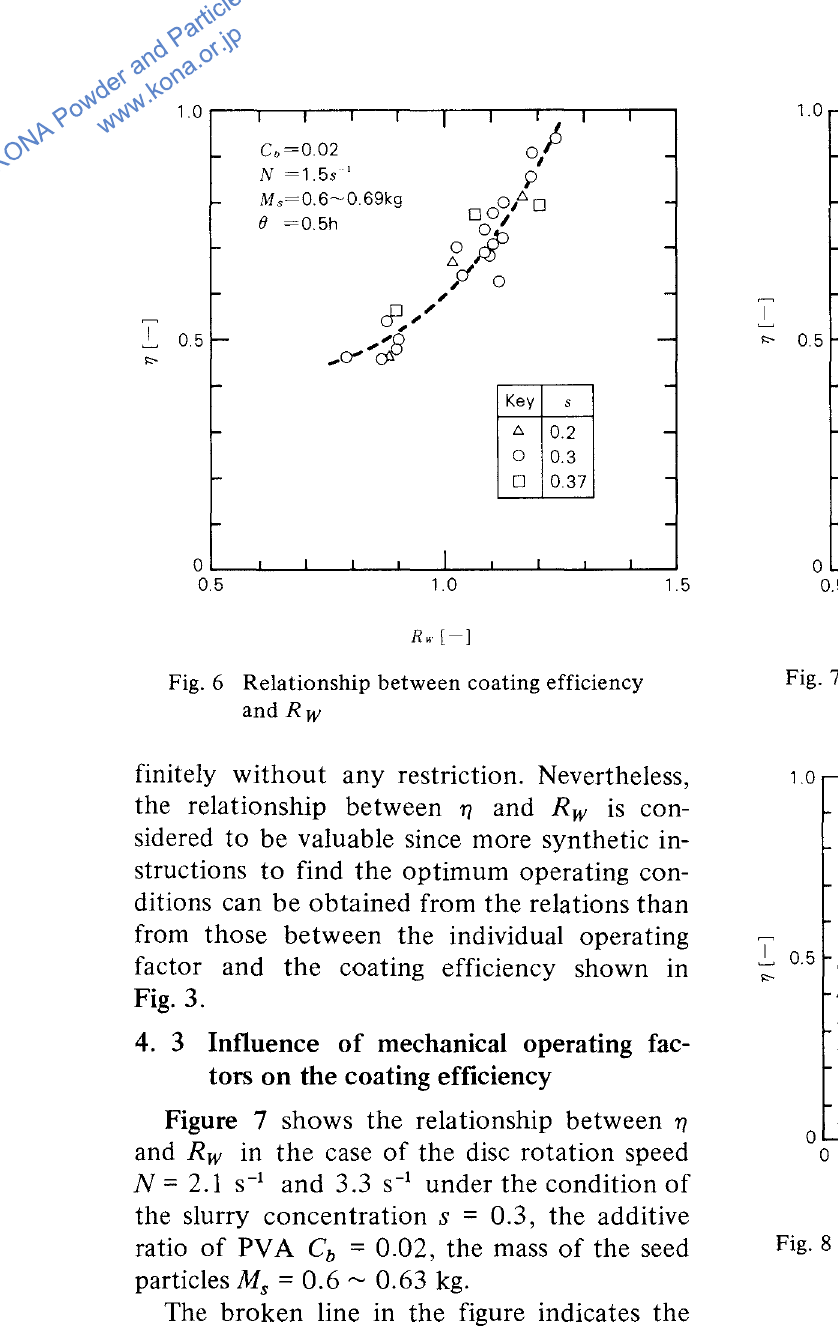
Fig. 8 Coating efficiency or coating ratios vs.